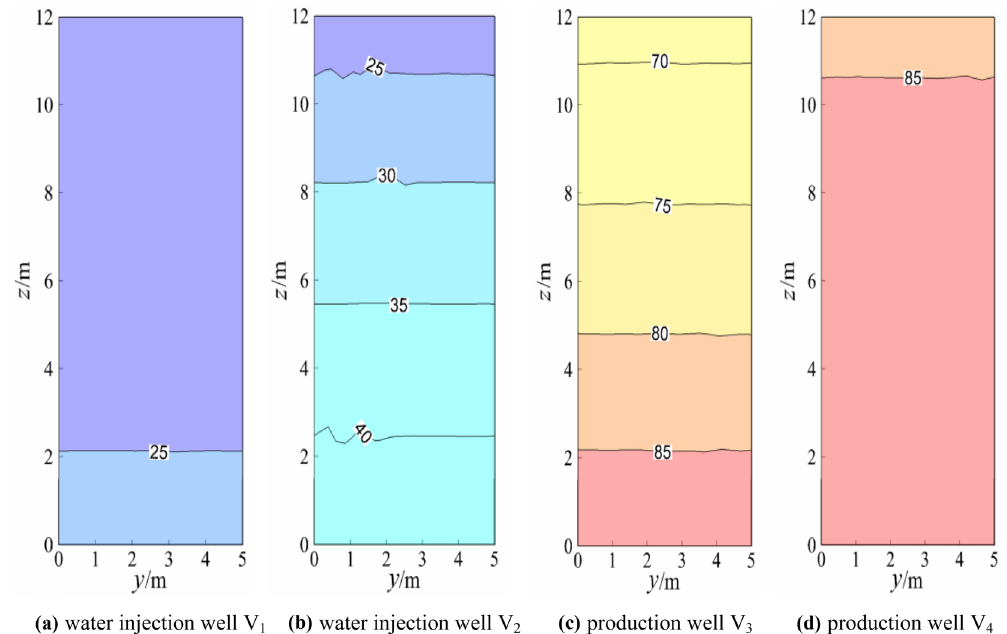
Figure 7. Temperature field of the geothermal well plane (working condition 3).